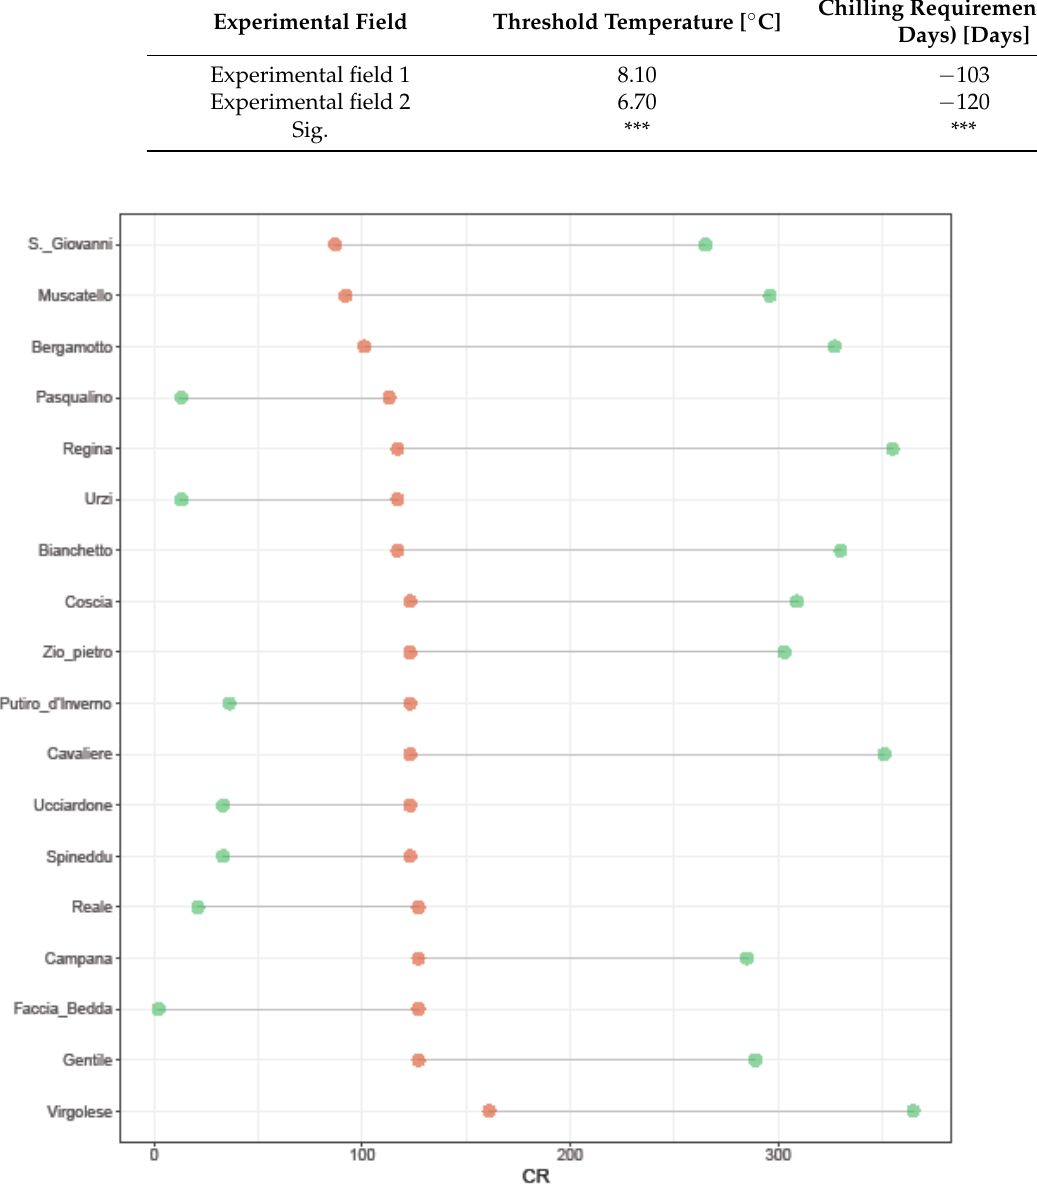
Figure 3. Chilling requirement (CR) of the 18 pear cultivars in both experimental fields (EF1 and EF 2). In green and red the CR values detected in EF1 and EF2, respectively.